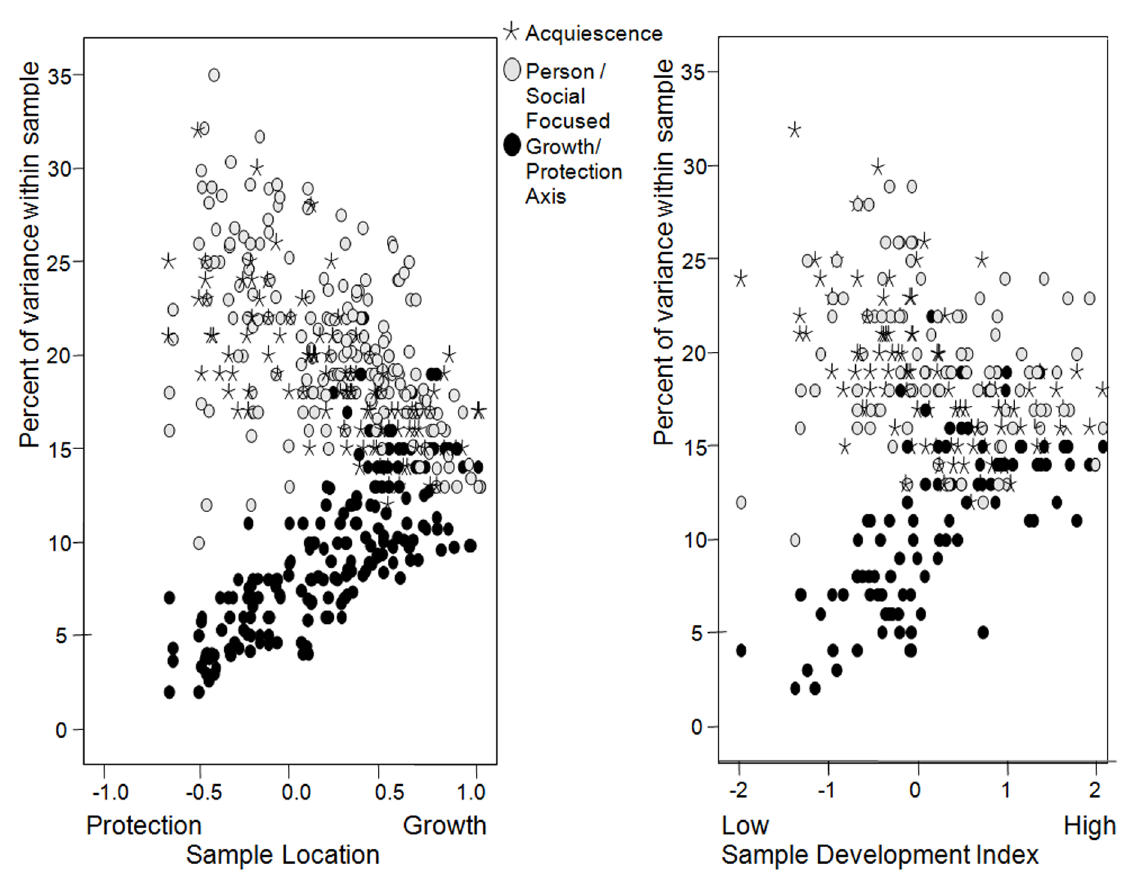
Figure 4. Plot of variance sources from CFA per sample with the mean location on the growth – protection values diagonal axis (left) and the socioeconomic development index